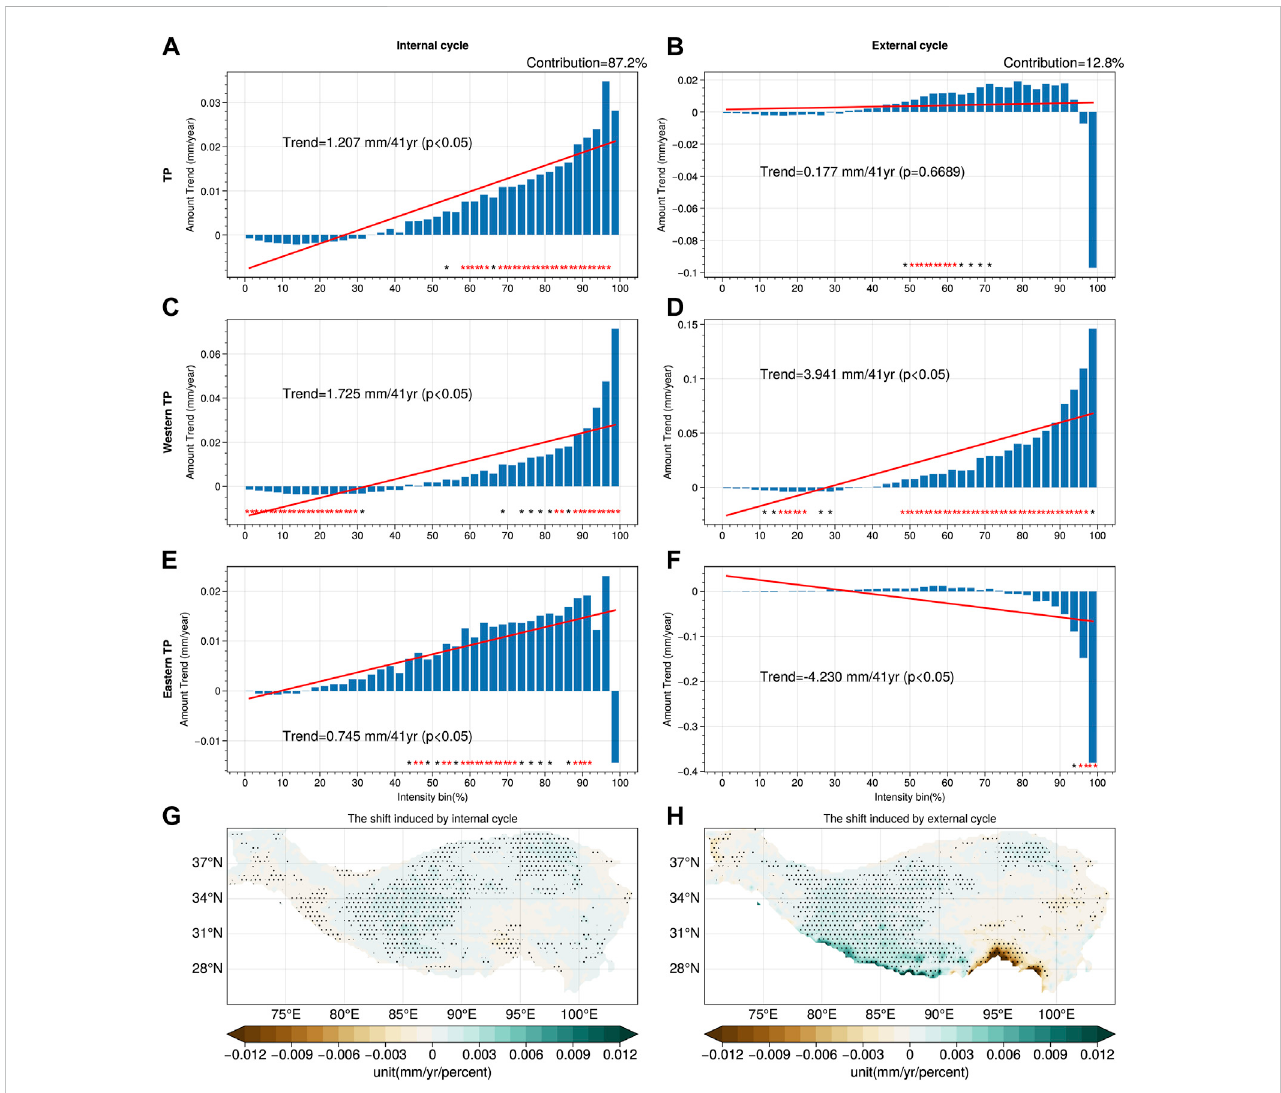
FIGURE 5 Distribution ofprecipitationtrendsinprecipitationpercentileintensitybinsofprecipitationandthespatial distributionofshiftratesduringthesummerof 1979 – 2019averagedovertheTP. In (A – F) ,linear trend(blue bars)inprecipitationassociated withinternal(left column)and external (rightcolumn)cycles asa function of 40 precipitation percentile intensity bins over the TP (A,B) , western TP (C,D) , and eastern TP (E,F) . The red lines indicate the shift rates of precipitationintensity.Ingandh,thetrendmapoftheshiftrateofprecipitationintensityinducedbytheinternal (G) andexternal (H) cyclesontheTP.The dotted areas and red stars indicate statistical signi fi cance exceeding 95%. The black stars indicate statistical signi fi cance exceeding